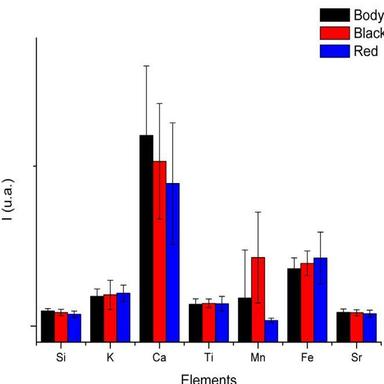
Average values of the XRF signals from bulk and black and red decorations. (For interpretation of the references to color in this figure legend, the reader is referred to the web version of this article.)